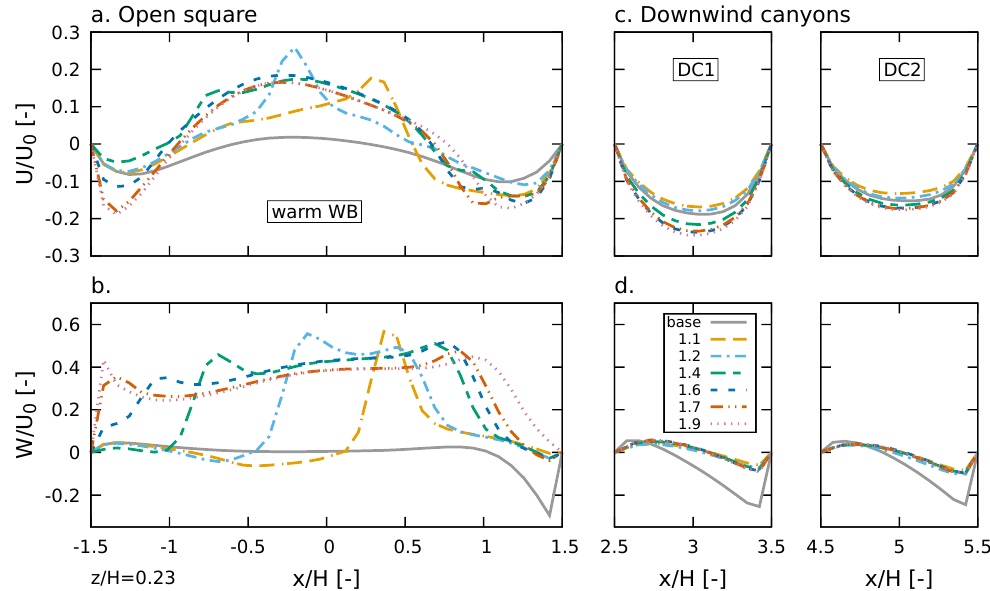
Figure 15. Profiles of normalised velocity ratios over a horizontal line across the middle of the domain ( y / H = 0) at pedestrian level ( z / H = 0.23) for the warm water body cases ( ∆ T = + 2 K) and for different water body shapes: ( a , b ) results within the open square ( − 1.5 ≤ x / H ≤ 1.5) for streamwise ( U / U 0 ) and vertical velocity ( W / U 0 ), respectively; ( c , d ) results within the downwind canyons (DC1: